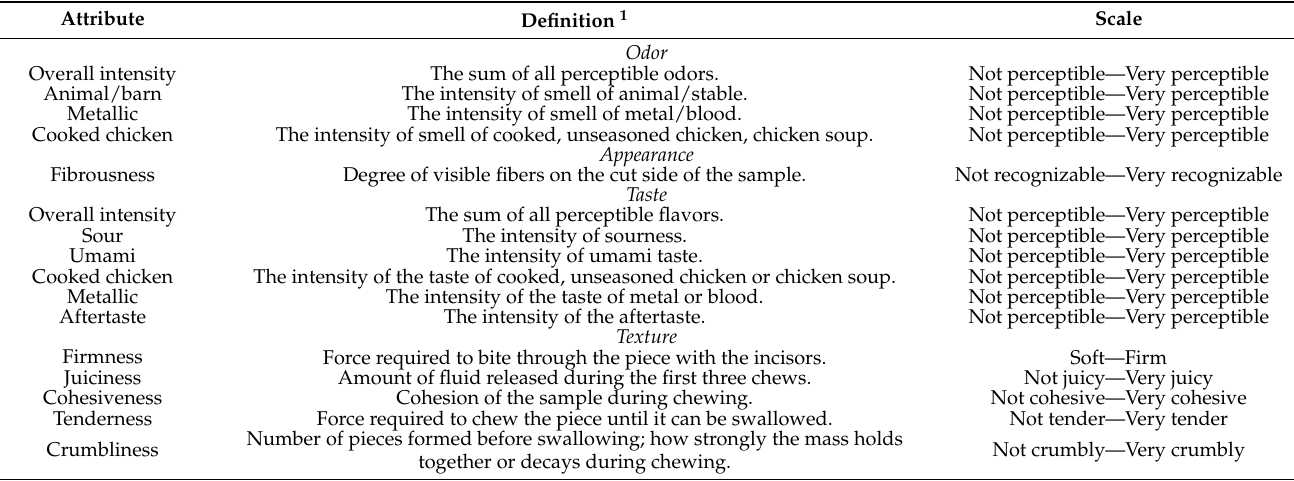
Table A1. Sensory attributes, definitions and scales used to evaluate